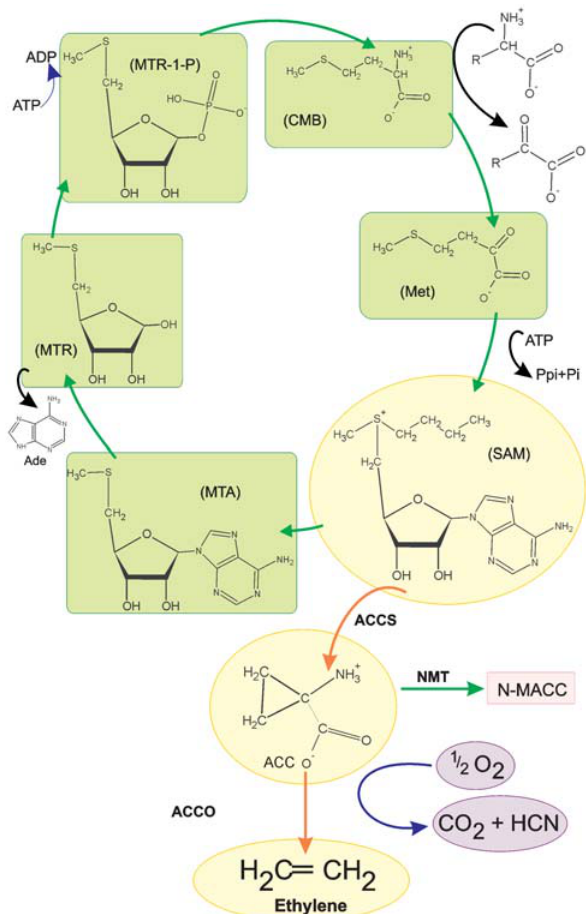
Figure 1 - Ethylene biosynthesis pathway (yellow) and its relationship to the methionine cycle (green). ACC: 1-aminocyclopropane-1-carboxylic acid;ACCS:ACCsynthase;ACCO:ACCoxidase;Ade:adenosine;ADP: adenosine 5’-diphosphate; ATP: adenosine 5’-triphosphate; CMB: 2-keto-4-metilbutyrate; MTA: 5’-metilthioadenosine; MTR: 5-metilthio- ribose; MTR-1-P: 5-metilthioribose-1-phosphate; N-MACC: N-malonyl ACC; NMT: N-malonyl transferase; SAM: S-adenosyl methionine (adap- ted from Yang and Hoffman,